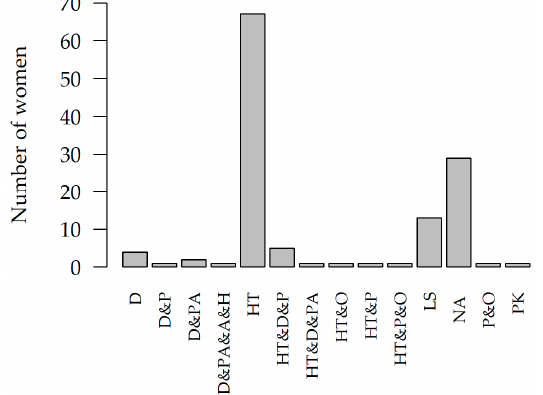
Figure 1. Treatments used among the subjects OX (D = Diet, PA = Physical Activity, P = Physiotherapy, O = Osteopathy, A = Acupuncture, PK = Pain Killer, HT = Hormonal Therapy, LS = Laparoscopy, H = Herbal, NA = Not Applicable, PS = Psychotherapy), OY (number of women undergoing treatment).